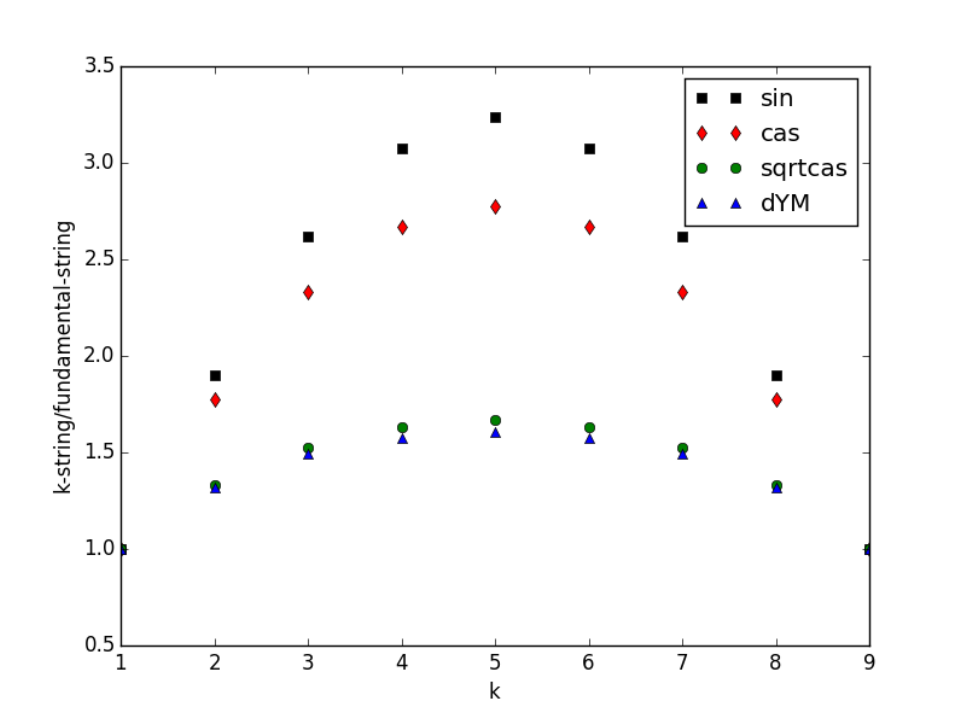
Figure 1 . Comparison of di(cid:11)erent SU(10) k-string ratios scaling laws with dYM k-string ratios, labeled by \dYM" (blue triangles). The Sine law is labeled by \sin," the Casimir scaling by \cas," and scaling with the Square root of the Casimir by \sqrtcas." From the known theoretical models predicting di(cid:11)erent scalings of k-string tensions, the ones we (cid:12)nd in dYM are closest to the MIT Bag Model \Square root of Casimir" k-string tension law. We argue that it gives an upper bound on dYM k-string